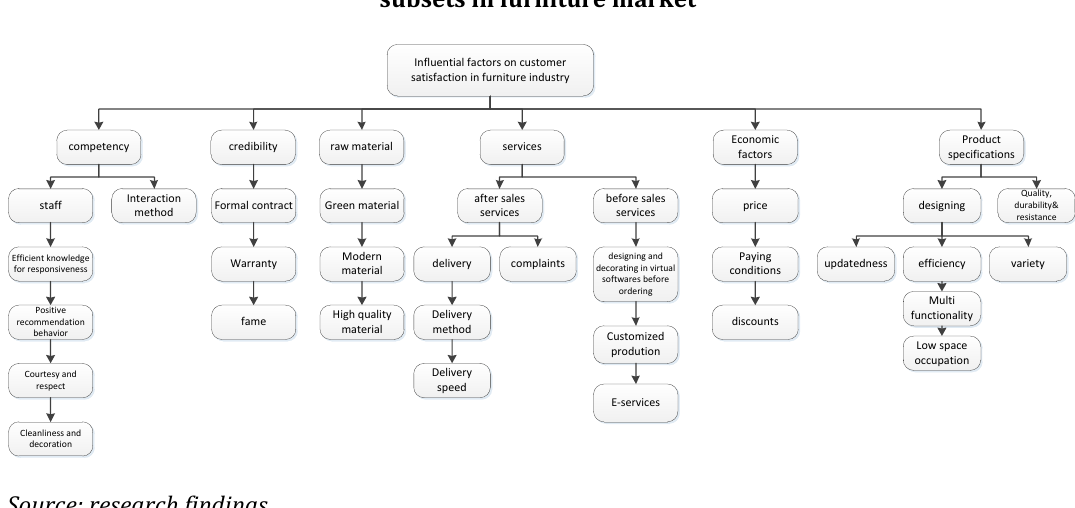
Figure 1: Decision making cluster (hierarchy) the customer satisfaction indexes beside their subsets in furniture